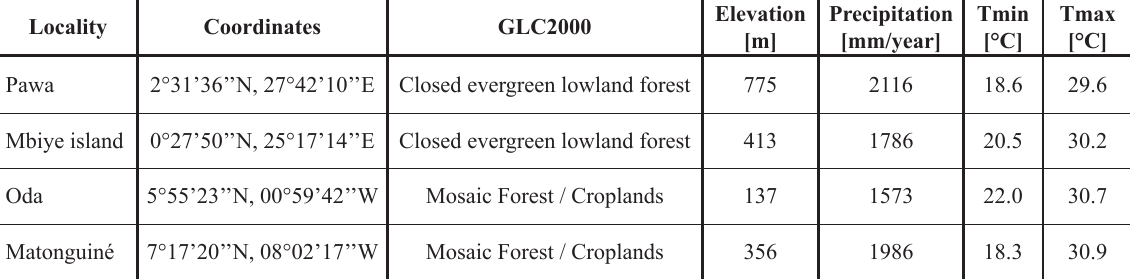
Table 4. Geographic and climatic data for the localities where Glauconycteris superba Hayman, 1939 has been collected. GLC2000 = Global Land Cover 2000 (Mayaux et al. 2004); Precipitation = annual precipitation; Tmin = mean annual minimum temperature; Tmax = mean annual maximum temperature (Hijmans et al.